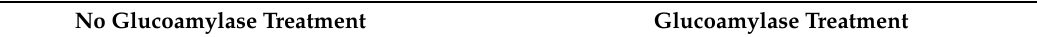
Table 1. Changes in sugar content and sugar consumption ratio before and after MR in meal